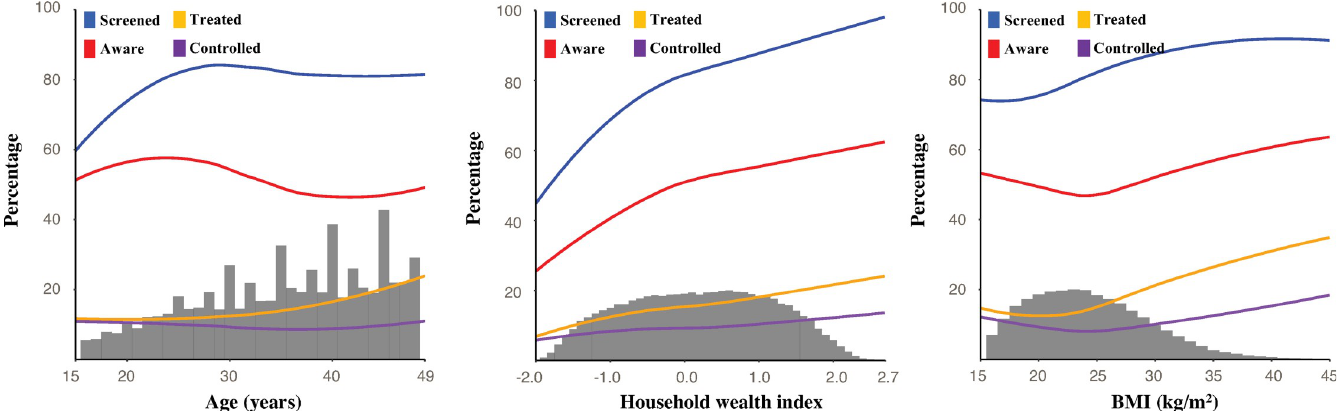
Fig 4. The predicted probability of reaching each cascade step by age, household wealth index, and BMI as continuous variables. Predicted probabilities were obtained from covariate-adjusted logistic regressions of hypertension care indicators on individuals’ sociodemographic characteristics (age, household wealth index, education, marital status, sex, rural versus urban location, BMI, tobacco consumption [smoking], and tobacco consumption [smokeless]) and district-level fixed effects. We used restricted cubic splines with 5 knots for each continuous variable (age, household wealth index, and BMI). Higher household wealth index values indicate more household wealth. A detailed description of all the household characteristics and assets included in this index can be found in Methods C in S1 Supplemental Materials. The grey histogram in the background represents the distribution of the variable on the x -axis, whereby the height of the histogram bars does not correspond to the percentages on the y -axis. The sample for each regression was all individuals with hypertension (i.e., the sample was not restricted to those who had reached the preceding cascade step).